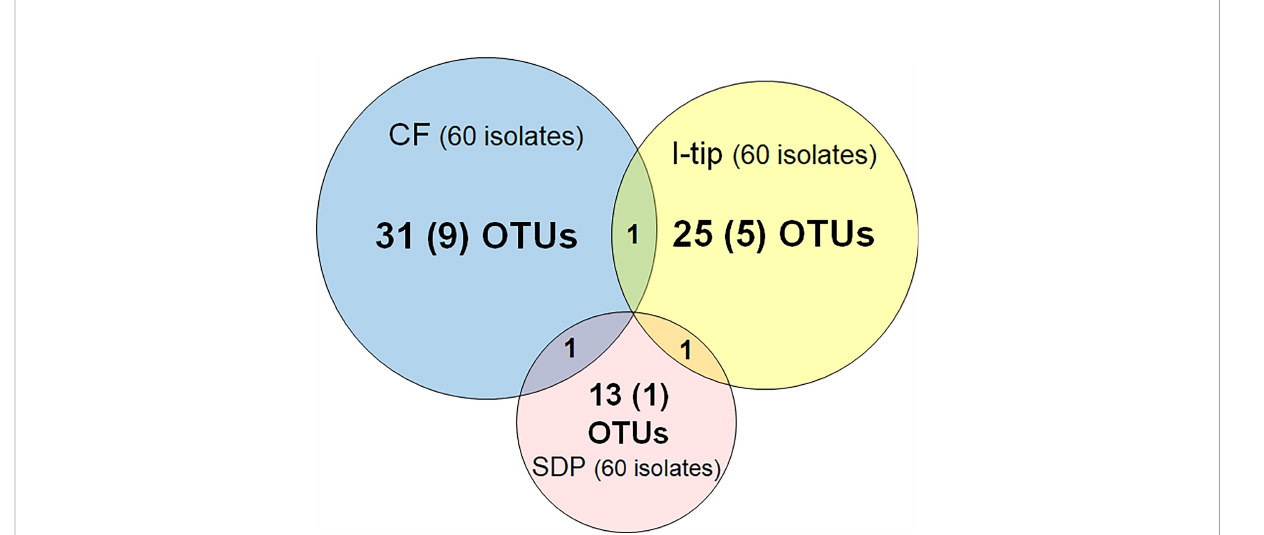
FIGURE 3 Overlap among culture collections obtained using three different cultivation approaches. Values in the center of each circle represent the total number of different isolated species (de fi ned as OTUs composed of 16S rRNA gene sequences sharing over 97% identity) by method; values in parentheses represent the numbers of novel species (de fi ned as a strain with ≤ 97% 16S rRNA similarity to the closest known relative among cultivated isolates); values in the overlapping areas represent the numbers of co-isolated species. Venn diagrams were made with Venn Diagram Plotter v. 1.5.5228.29250 (Paci fi c Northwest National Laboratory http://www.pnl.gov/;